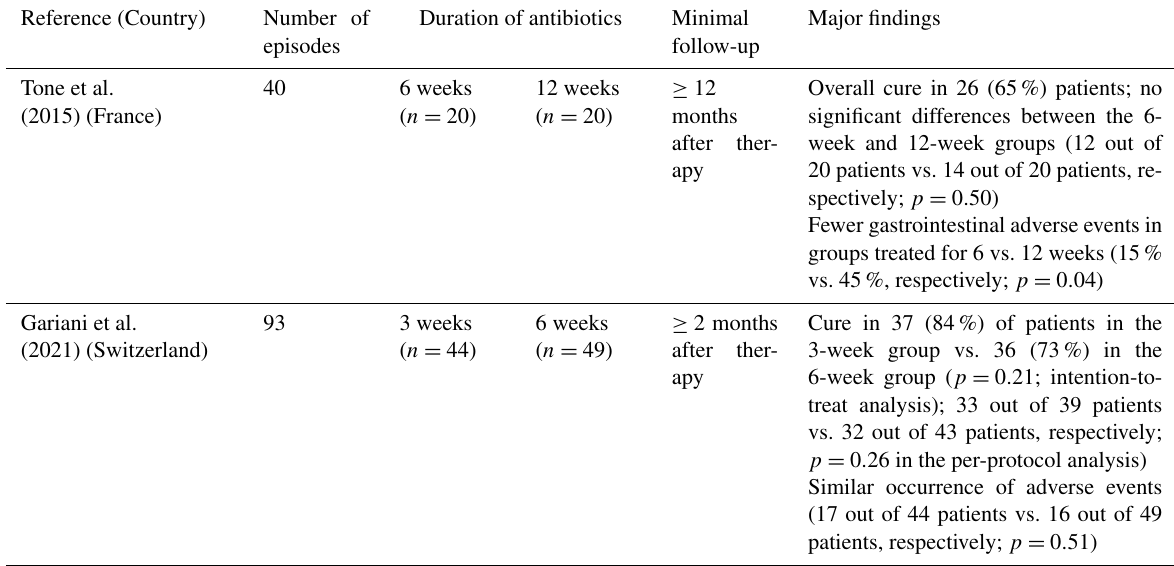
Similar occurrence of adverse events (17 out of 44 patients vs. 16 out of